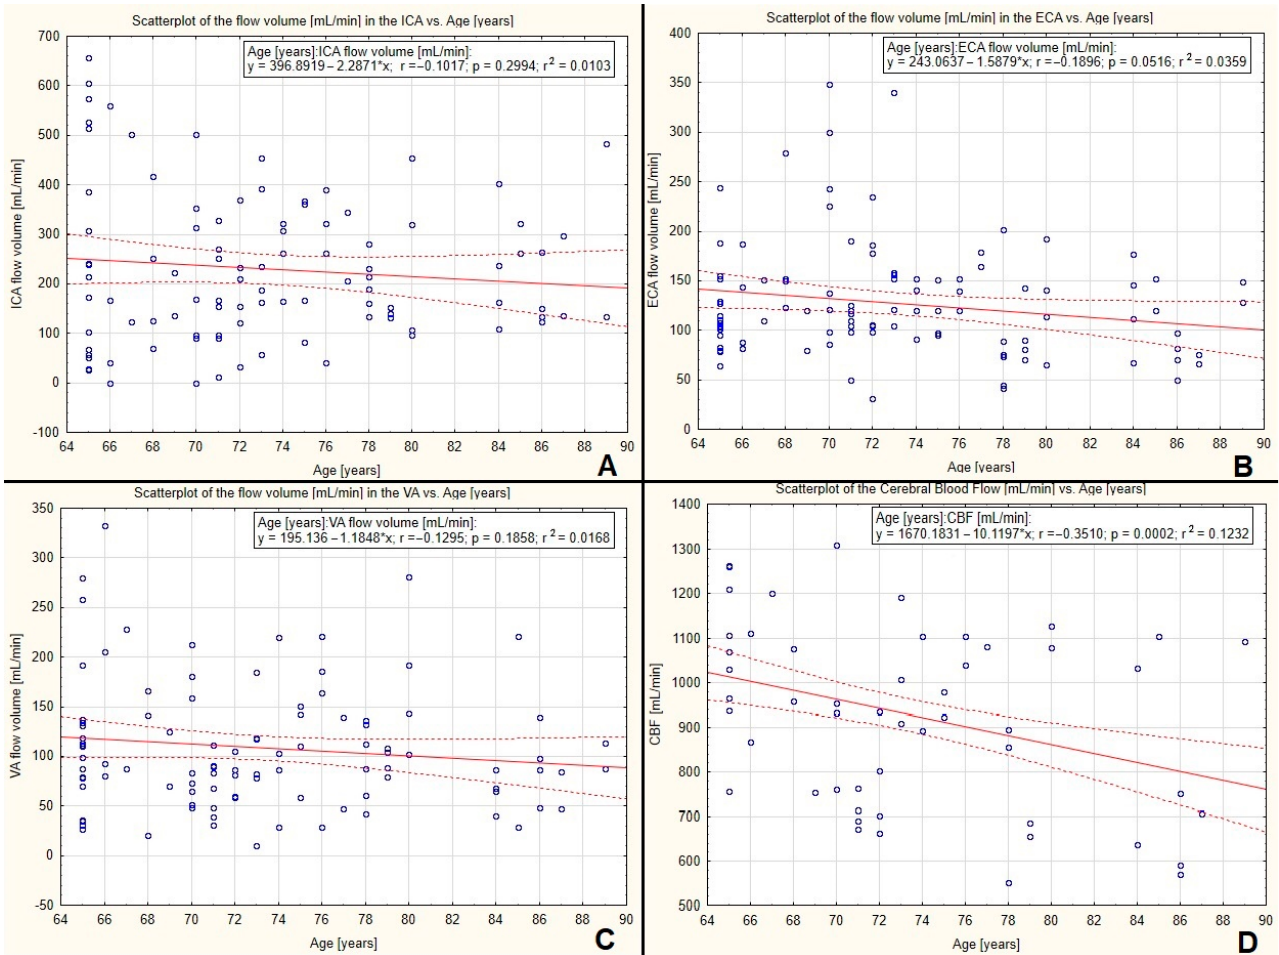
Figure 6. Regression analysis between blood flow volume in extracranial vessels: ICA ( A ), ECA ( B ), VA ( C ), and CBF ( D ) with age. A slightly decreasing, non-significant correlation between blood flow volume in the ICA, ECA, and VA was observed—( A ), ( B ) and ( C ), respectively. Statistically significant decreasing correlation between the CBF and increasing age ( p = 0.0002) was noted—( D ).